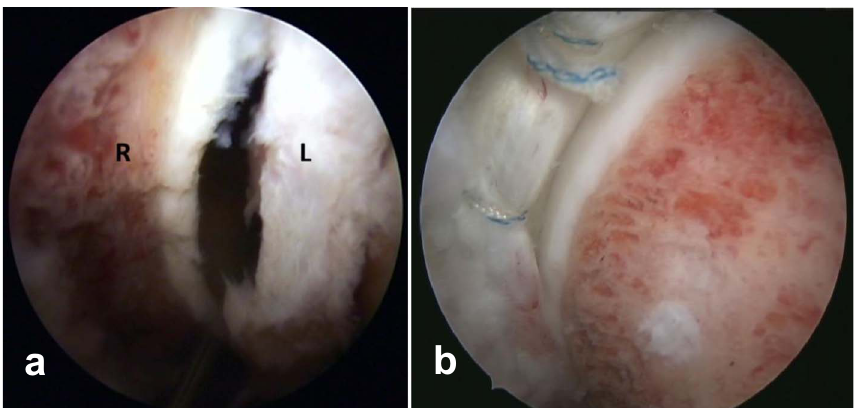
Figure 2. Acetabular rim trimming after labral separation (a). End result after cam osteoplasty and labral repair using suture anchors (b). L: Labrum, R: acetabular rim.